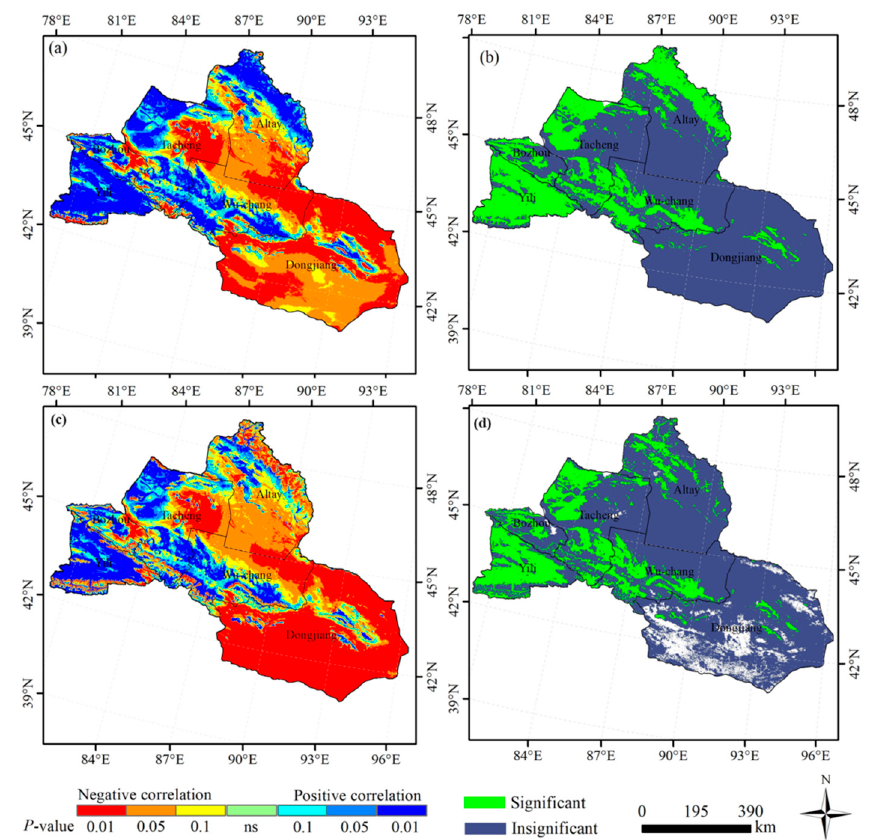
Figure 6. Regional differences of the correlation coefficients between the average NDVI and inter-annual variability of precipitation ( a,b ) and temperature ( c,d ).